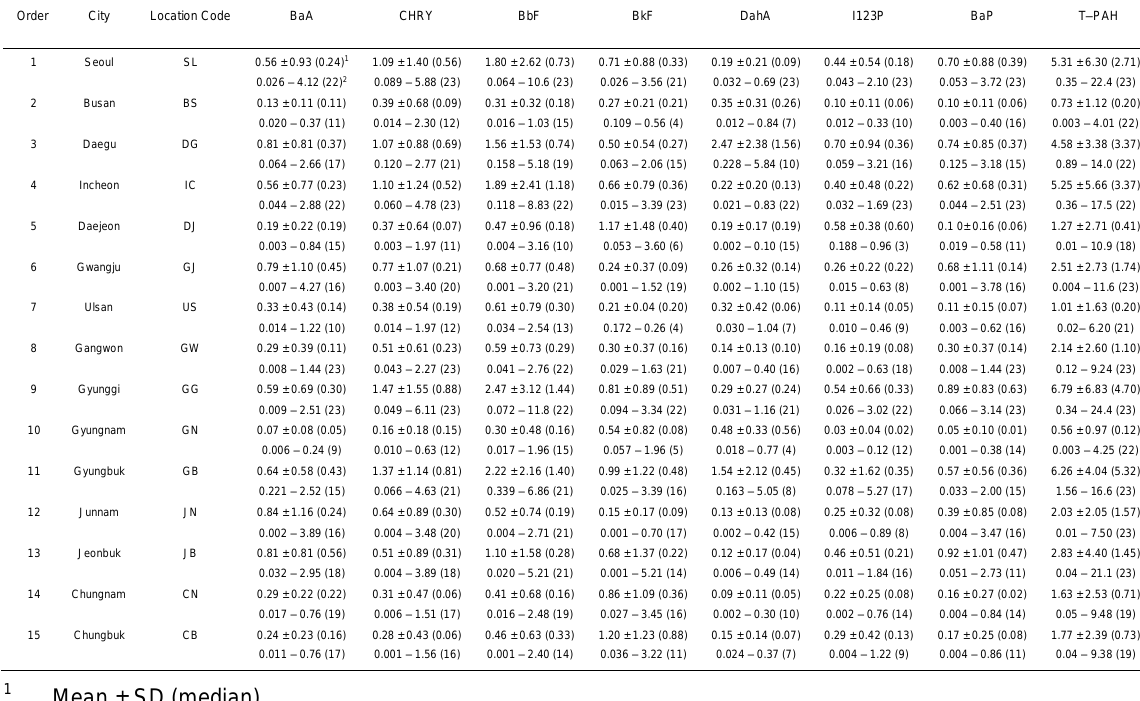
Concentrations of PAH Measured from Cities (1-7)/Provinces (8-15) during the Study Period (All Units in ng m – 3